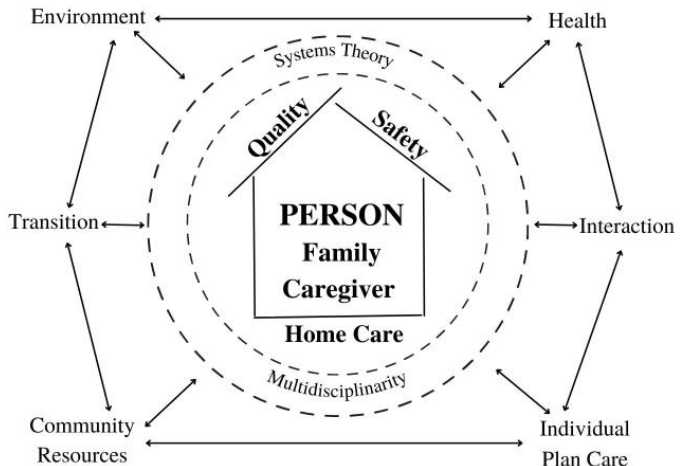
Figure 1. Patient Quality and Safety in Home